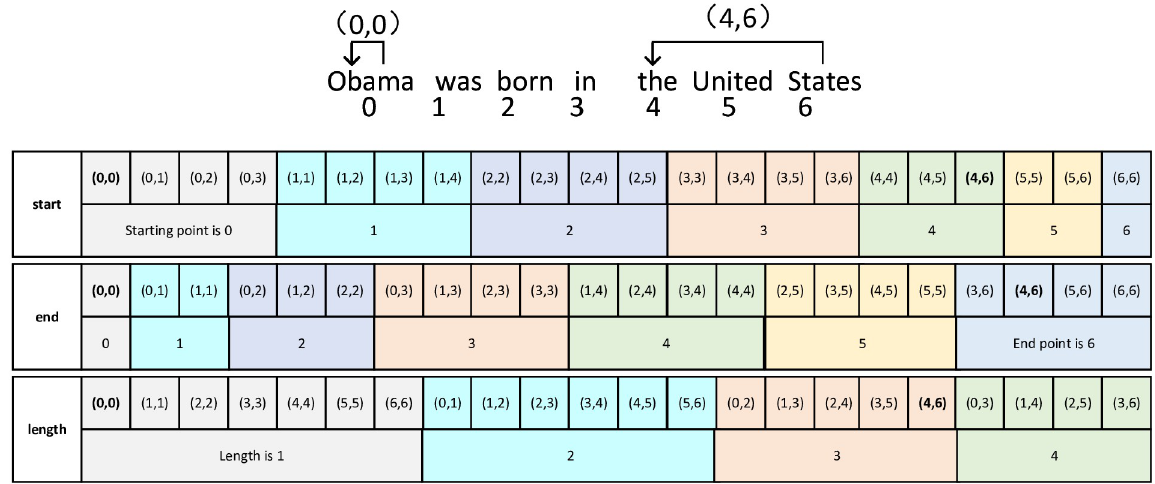
Fig 2. Example of span-tagger. (window length is 4). The value in the matrix is the tag value of span, and its position is the index of span. According to different span mapping strategies, the specific location index in the span embedding matrix is different. Span mapping strategy with the same starting point: fix the starting point of the span in the text, change the span length by changing the ending point of the span, until the span length reaches the maximum length of the window, and train the spans with the same starting point together, as shown in the first line of the figure; The mapping strategy for spans with the same endpoint is just the opposite: tag the span by fixing the endpoint of the span, changing the starting point of the span, and train the spans with the same starting point together, as shown in the second line of the figure; Mapping strategy of the same span length: the fixed window length traverses the text, and then increases the window length to traverse the text again until the maximum window length is reached, and the spans with the same length are trained together, as shown in the third line of the